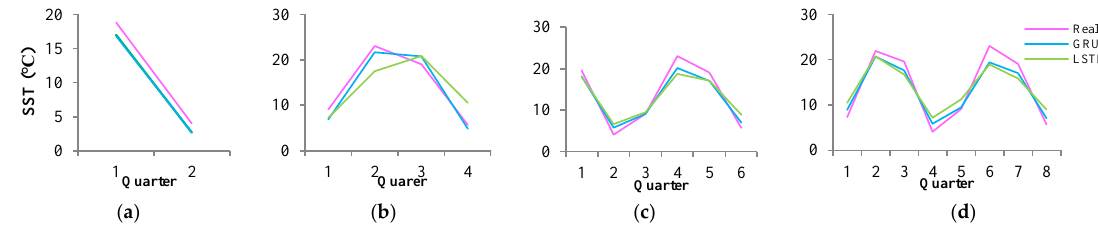
Figure 12. Prediction results under different quarterly lengths for the P2 site. ( a ) Prediction for the last 2 quarters; ( b ) Prediction for the last 4 quarters; ( c ) Prediction for the last 6 quarters; ( d ) Prediction for the last 8 quarters.